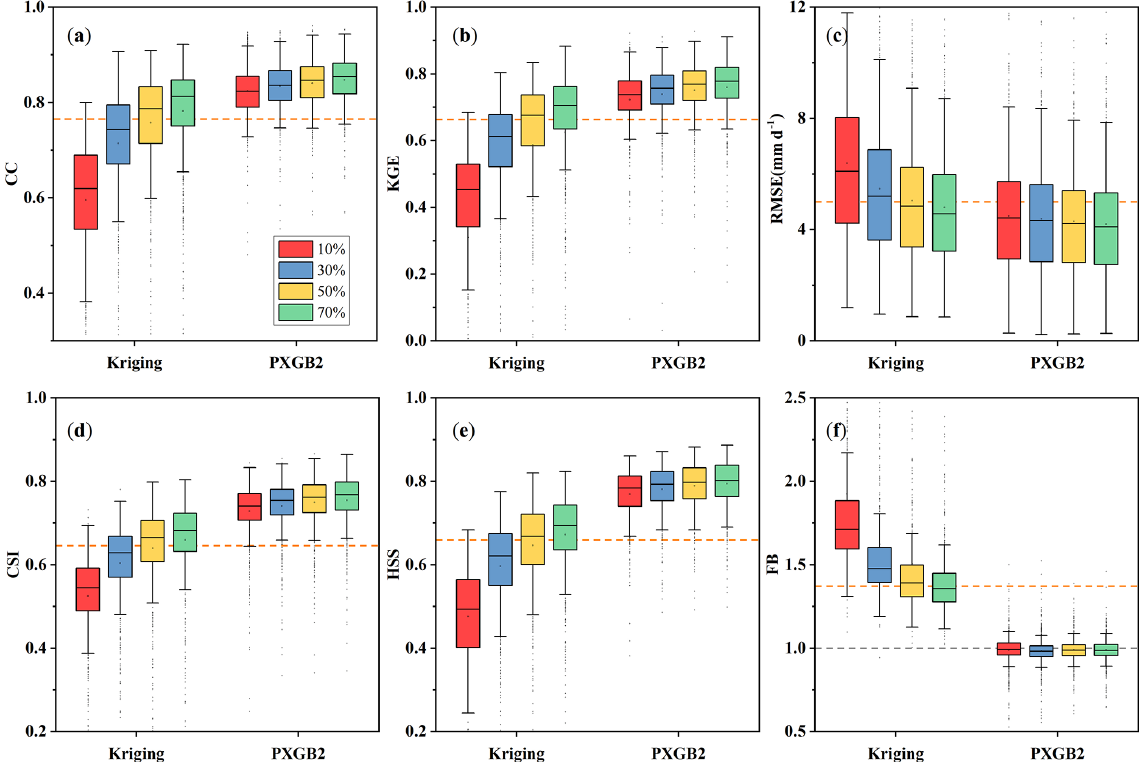
Figure 13. Performance of PXGB2 and Kriging products using training dataset with different rain gauge densities (10%, 30%, 50%, 70%). The dotted orange line in (a) – (f) shows the average of the best original product (GSMaP). The dotted gray line in (f) represents the reference line with a value of